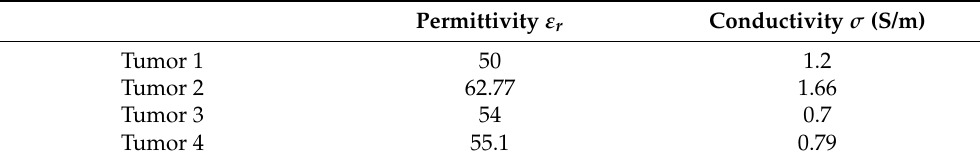
Table 3. Dielectric properties of different tumor